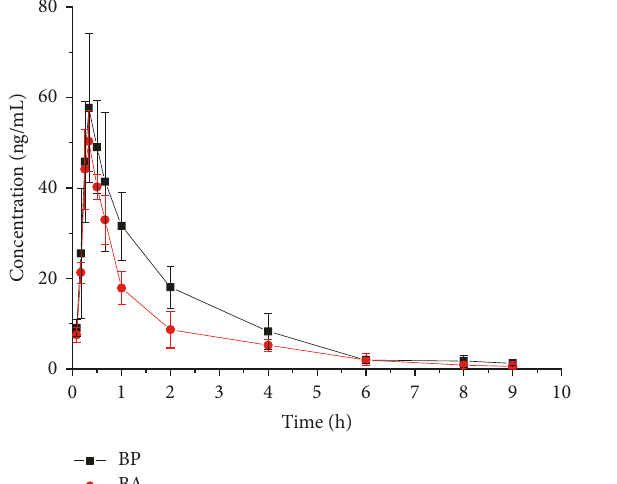
Figure 4: Typical MRM chromatograms of IS, BP, and BA: (a) blank rat plasma; (b) blank rat plasma spiked with IS (I, 100ng/mL), BP (1ng/mL), and BA (1ng/mL); (c) rat plasma sample at 20 min after intragastric administration of BP spiked with IS; Roman numerals: I for IS, II for BP, and III for BA.